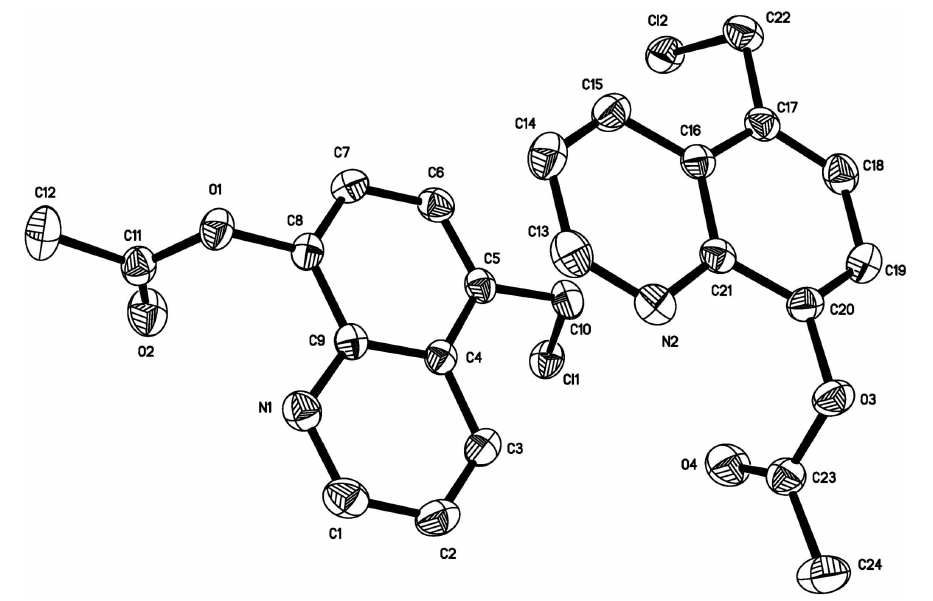
Figure 1 Two independent molecules in the title compound, with displacement ellipsoids drawn at the 50% probability level. H atoms have been